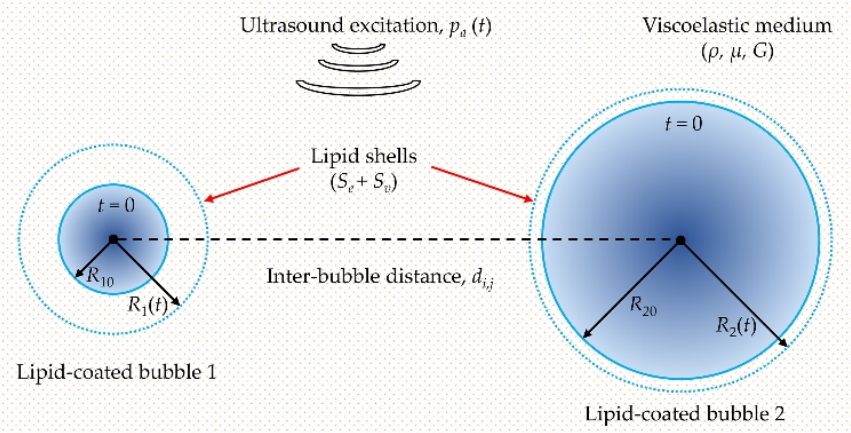
Sojahrood et al. provided a review of the time delays in the simulation of interacting bubbles [54].